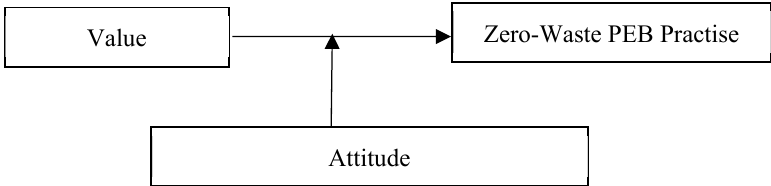
Figure 6. The schematic diagrams showing the positions of the independent (Value), dependent (A tt itude), and moderating (Practise) variables.